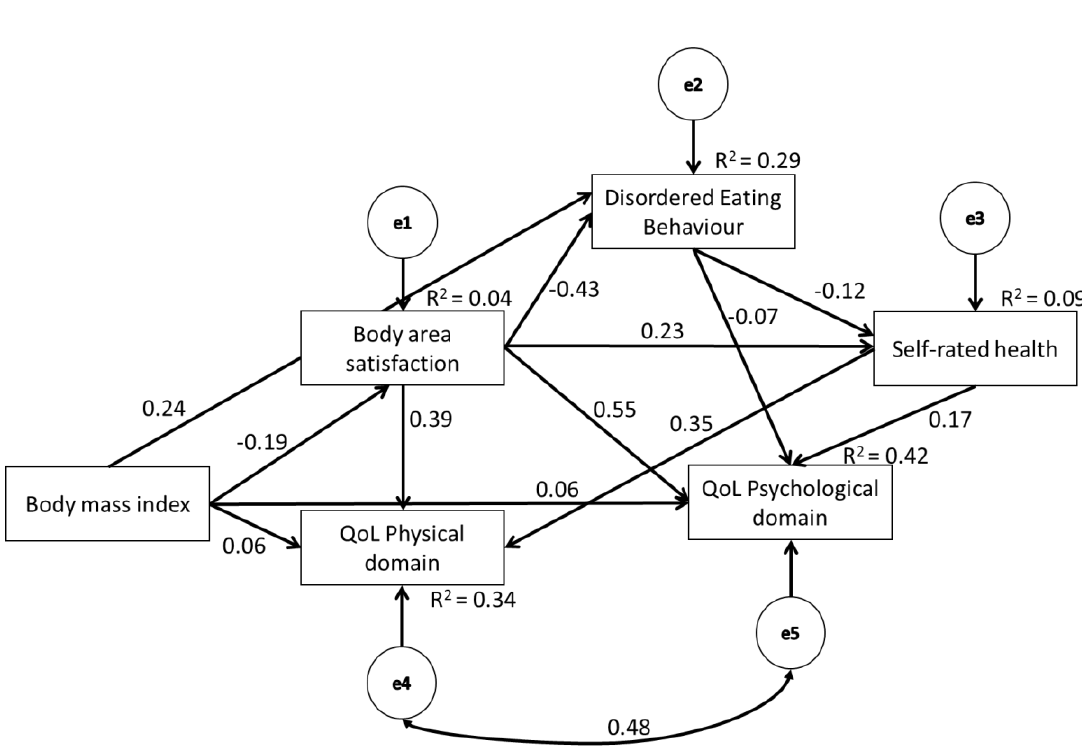
Figure 1. The final path model ( n = 1850). Note: all standardized path coefficients are significant ( p < 0.05); QoL—quality of life.